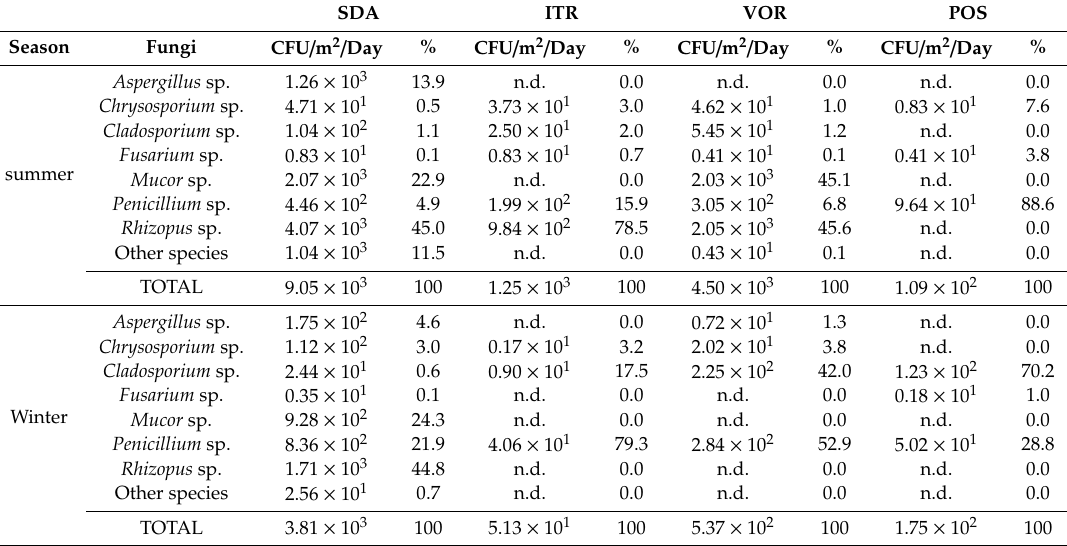
Table 8. Fungal levels found in EDCs during azole screening, per